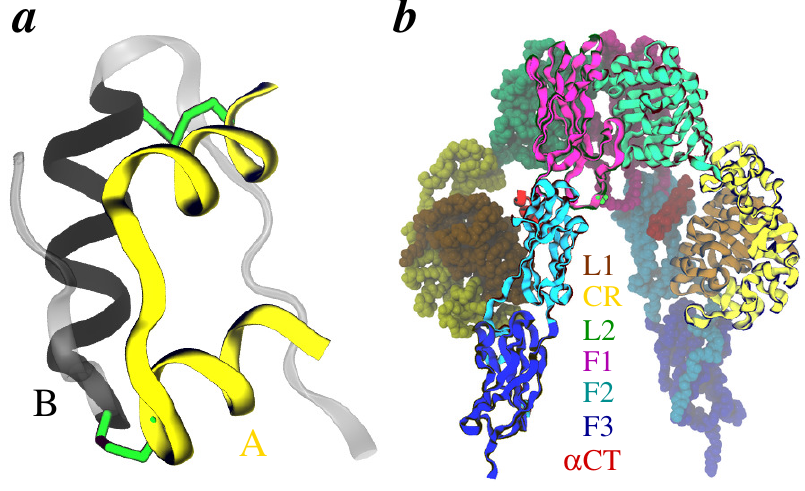
Figure 1. Three-dimensional folds of insulin and the IR ectodomain. ( a ) Helices in individual chains of hormone (PDB code 4INS) are rendered as yellow (A-chain) and black (B-chain) cartoons, while the flexible N- and C-termini of B-chain are transparent cartoons. ( b ) IR ectodomain homodimer (PDB code 3LOH) is shown with domains of one subunit as ribbons, while identical domains of the other subunit as space-filling. Individual domains are uniquely colored and labeled ( α CT stands for the helical C-terminal segment of each α -chain of IR). Two interchain disulfide bonds in insulin and one in the receptor are shown in green sticks. In all panels, only backbone atoms are rendered for